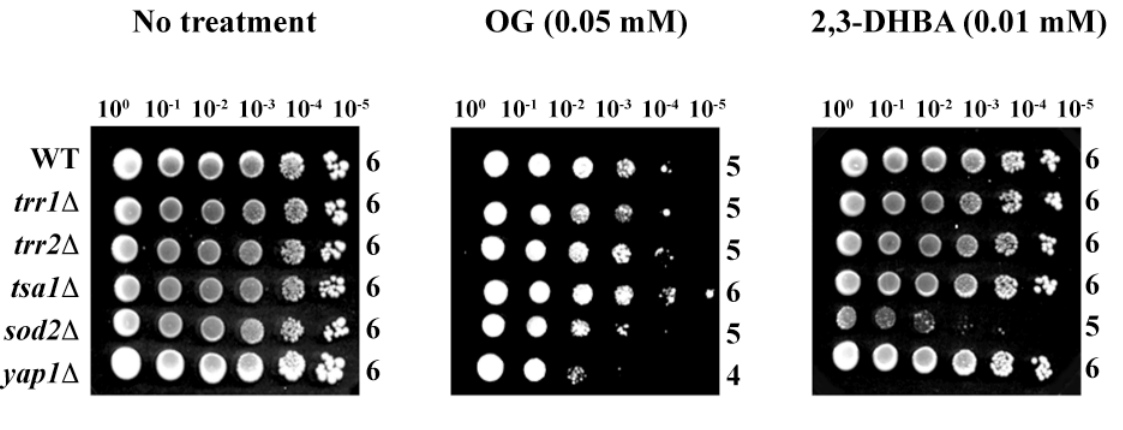
Figure 4. Agar plate-based yeast dilution bioassay identifying sensitive mutants of S. cerevisiae to phenolic chemosensitizers (10 0 to 10 − 5 : yeast dilution rates). Results